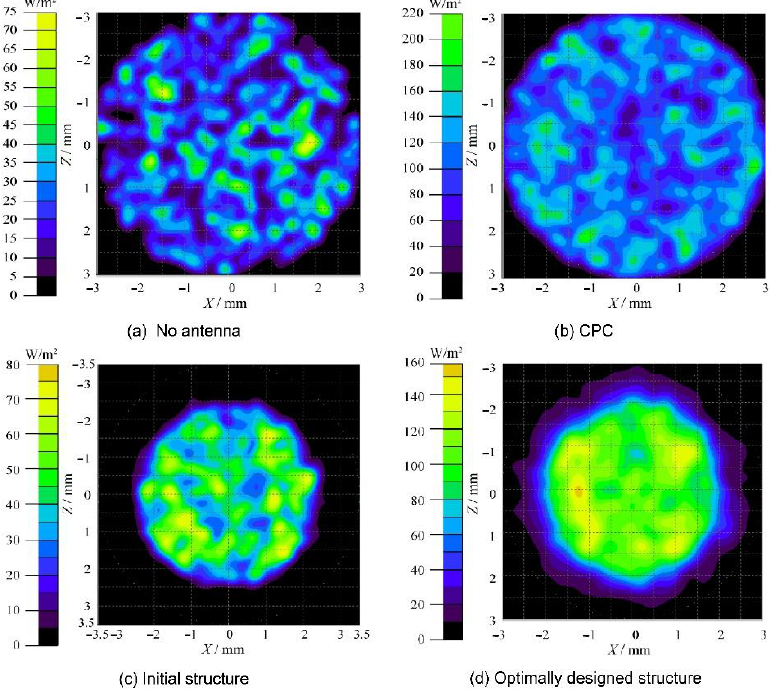
Figure 13. Diagram of the spot areas: no receiver ( a ); CPC ( b ); initial structure ( c ); optimally designed structure ( d ).